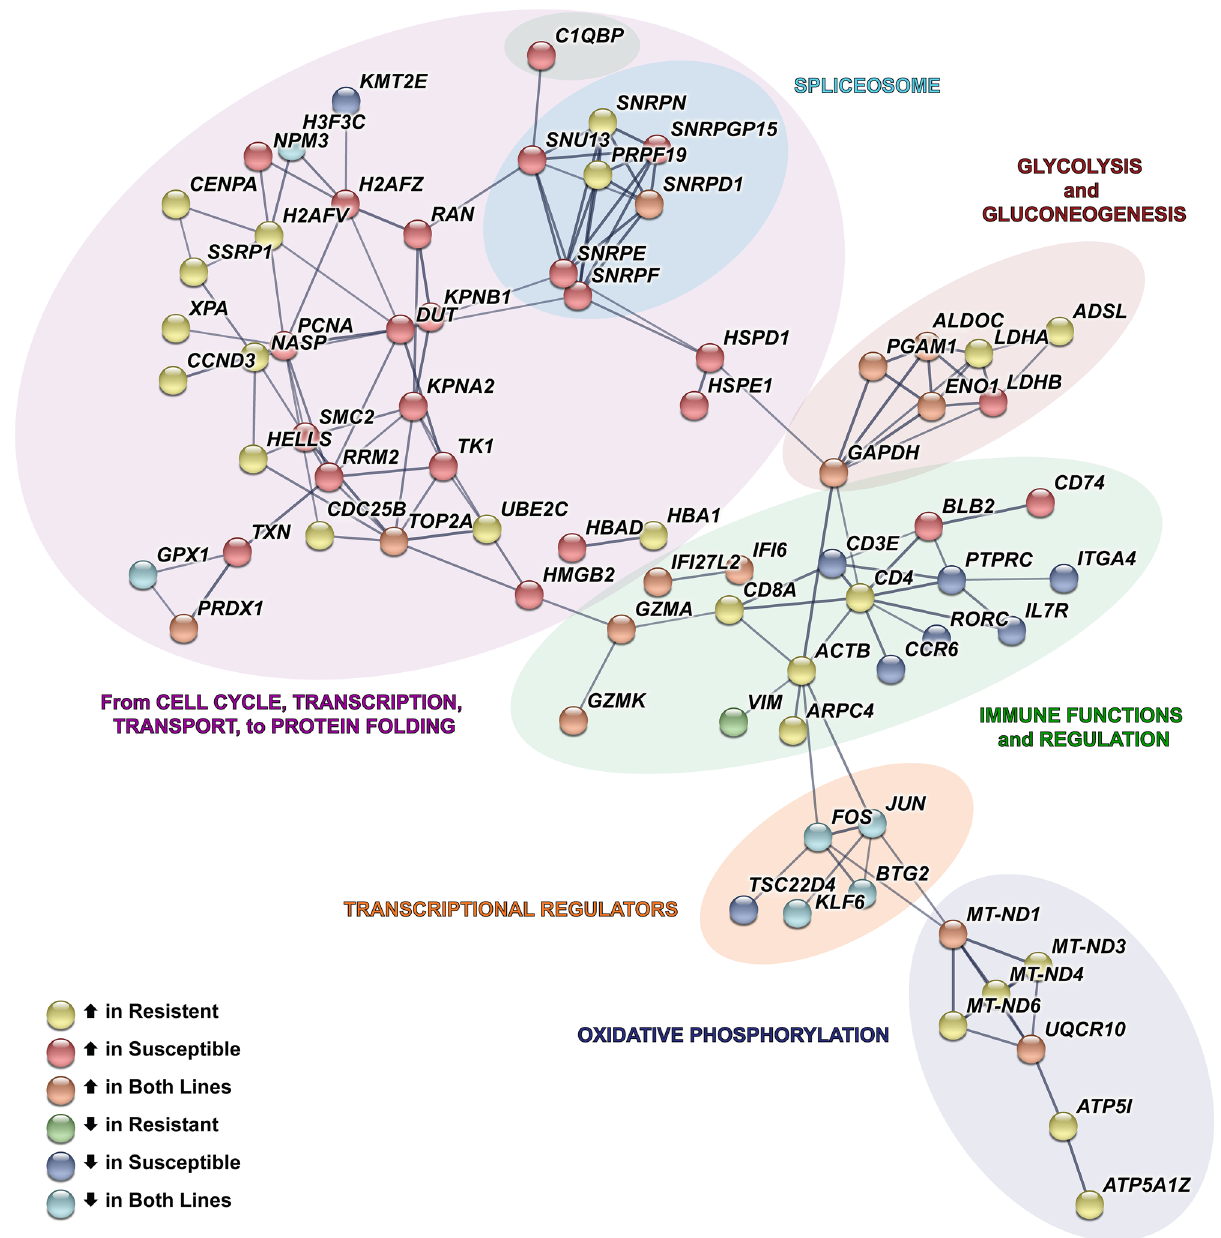
Figure 6. Network of DEGs in T cells (γδ enriched) after MDV infection. Within this cell type, connections between the significant differentially expressed genes (DEGs) from both lines cumulatively were identified using STRING (PPI enrichment p = < 1.0e − 16). For each DEG, the direction of log 2 FC (MDV-infected compared to control) is shown by the fill color for its node. Edges (line thickness) represent the strength of connections (interaction scores) between DEGs. Background colors represent broad-level functions associated with the DEGs in each branch of the